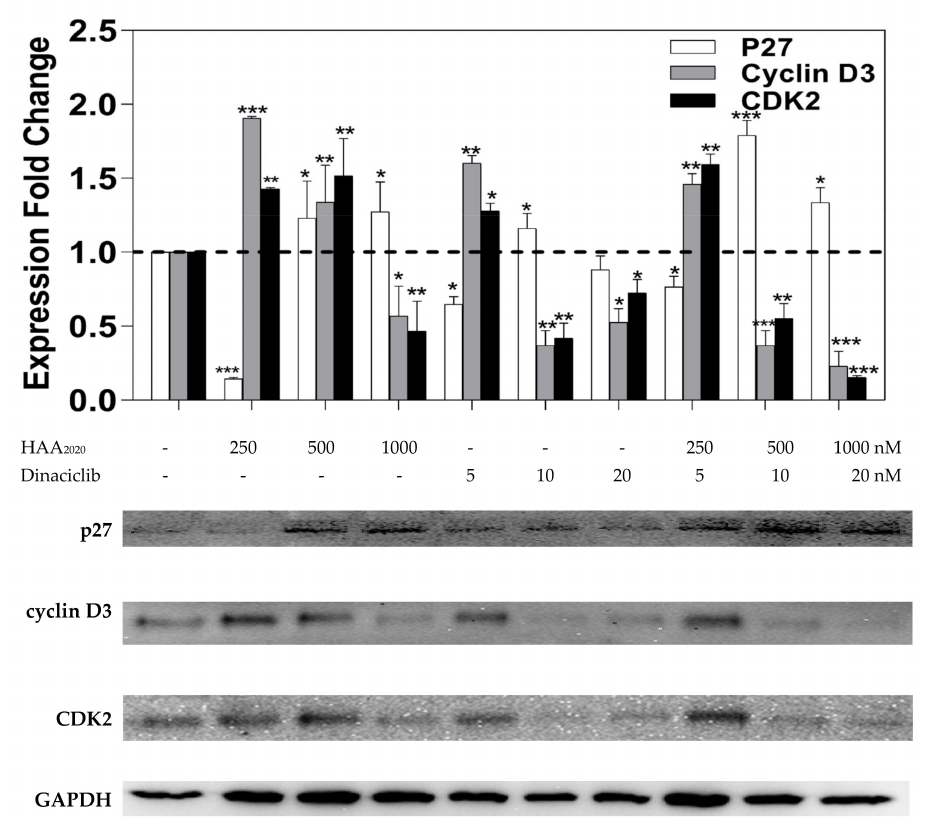
Figure 7. Expression of p27, cyclin D3 and CDK2 in HL60 cells treated with either HAA 2020 , dinaciclib or their combination as above for 6 h. Data are represented as mean ± SEM ( n = 2, two independent experiments). The result was normalized as fold-change compared with the untreated group. Ratio above 1 (dashed line) shows the amount of mRNA for the three genes in the untreated cells (control = 1). Statistical di ff erences, compared with the untreated control cells, were assessed by a one-way ANOVA with the Tukey’s post-hoc multiple comparison test. p < 0.05 (*), p < 0.01 (**)